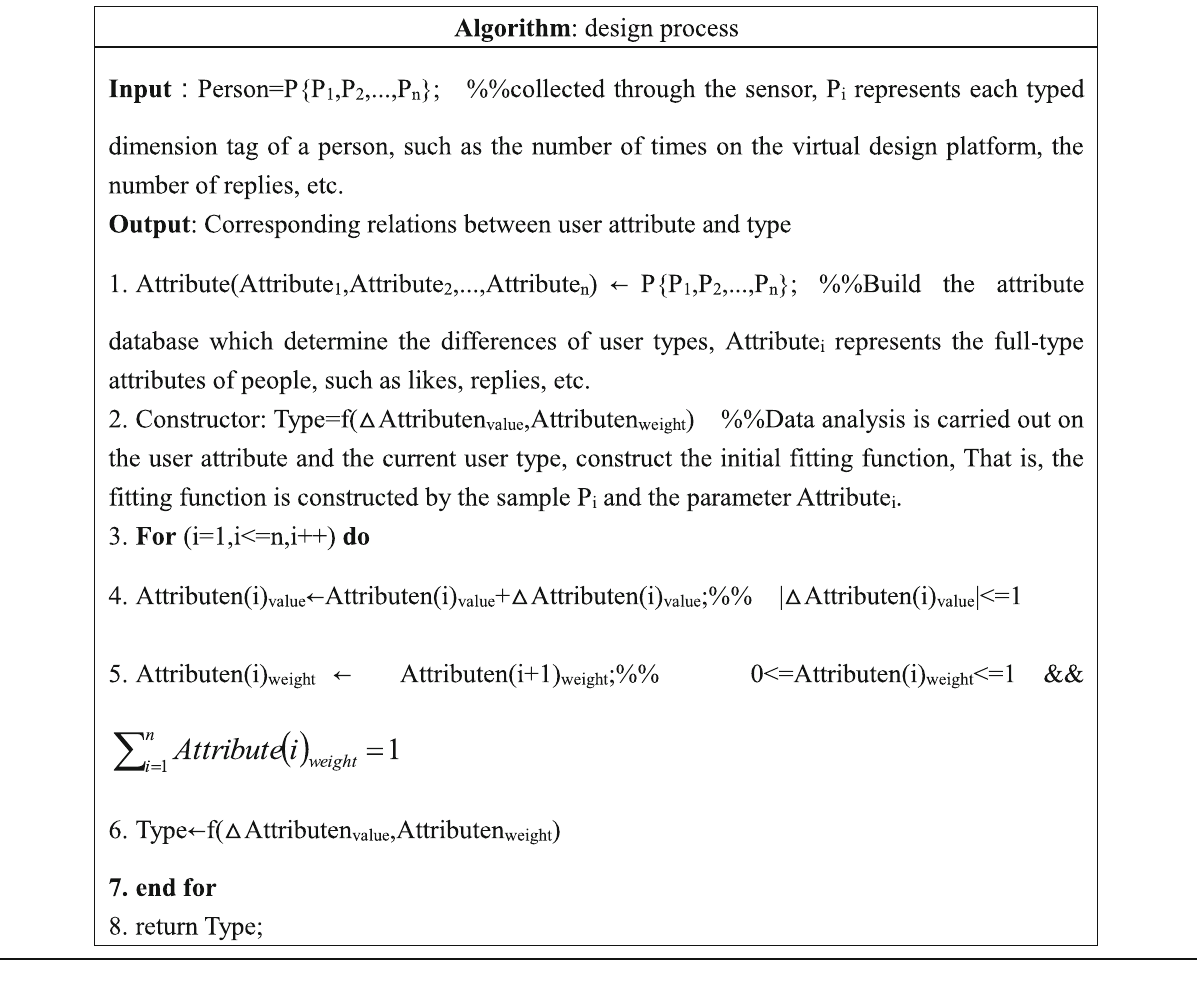
Table 7 Algorithm description of numerical